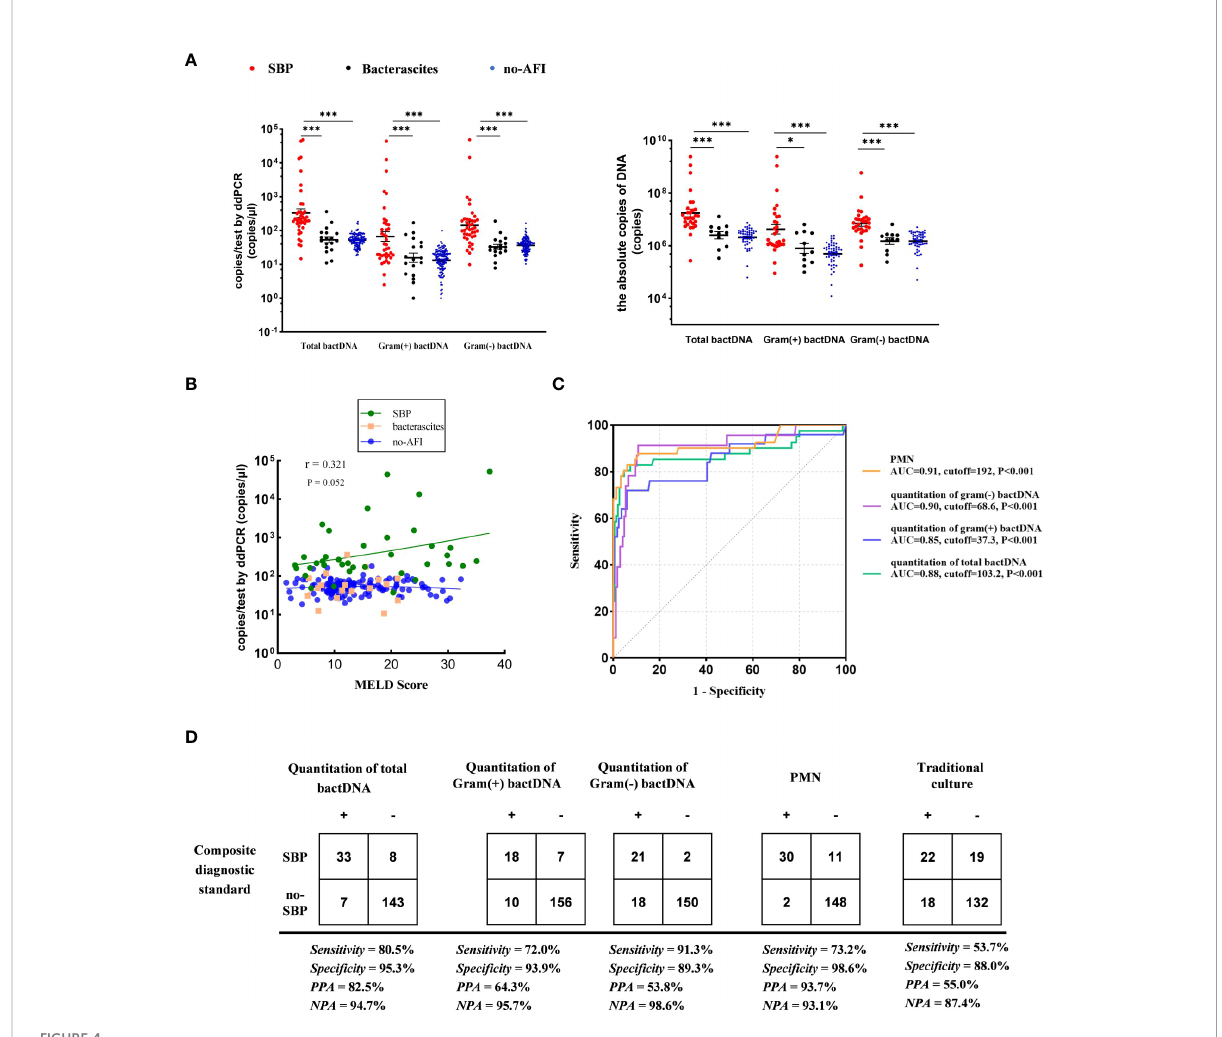
FIGURE 4 Accuracy of ddPCR testing in ascites. (A) Samples from 41 patients with SBP, 18 patients with bacterascites, and 132 patients with no-AFI. In the left panels, we compared the concentration of bactDNA. In the right panels, we obtained the absolute copies of bactDNA combined with ascitic volumes using virtual ultrasonography “ three-point method ” . (B) Correlation of bactDNA load with MELD. (C) ROC curves of bactDNA load from 191 samples based on clinical composite standards. (D) The 2 × 2 contingency tables for the validation of the quanti fi cation of bactDNA based on a clinical composite standard. MELD, Model for End-Stage Liver Disease; ROC, receiver operating characteristic; PPA, positive predictive agreement; NPA, negative predictive agreement; *P < 0.05, **P < 0.01, and ***P <